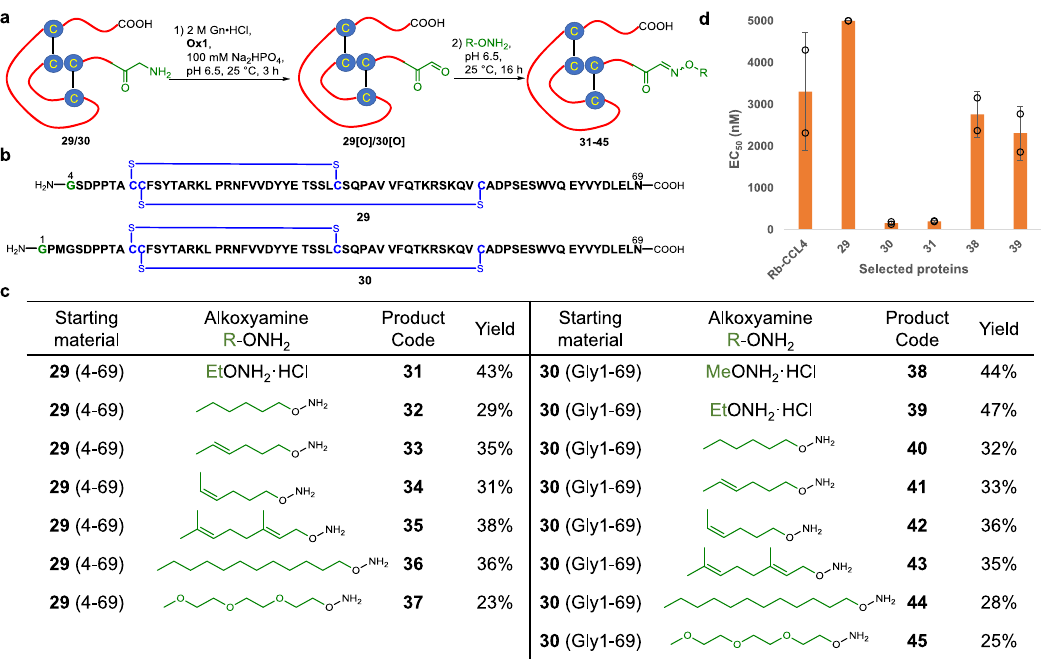
Fig. 6 Late-stage modi fi cation of MIP-1 β proteins via quinone-mediated selective oxidation of N -terminal amine. a Reaction scheme for the transamination of MIP-1 β protein 29 and 30 ; b The sequences of protein 29 and 30 ; c A summary of the transamination/oxime ligation of protein 29 and 30 and the isolated yields for all reactions; d Anti-HIV-1 activity of selected MIP-1 β analogs with EC 50 < 5000nM (Error bars represent standard deviation, n = 2 biological independent protein. Various alkyl alkoxyamines were chosen to optimize the comparison. Ox1 was added into the target protein 29 or 30 in anti-HIV-1 activity of MIP-1 β according to their hydrophobicity buffer solution at pH 6.5 and the solution was incubated at 25 °C (Fig. 6a). Hexyl, ( E )-hexyl, ( Z )-hexyl, geranyl and decyl hydro- for 3 h. Subsequently, after the addition of the alkoxyamine, the xylamine were used to investigate the in fl uence of the hydro- mixture was readjusted to pH 6.5 and reacted for a further 16 h to carbon chains with different conformation or chain lengths afford modi fi ed proteins 31 - 45 (Fig. 6c). MIP-1 β proteins and toward fi ne-tuning the bioactivity (Fig. 6c). In addition, we also MeONH 2 ·HCl or EtONH 2 ·HCl were dissolved well in this buffer solution, and the ligations proceeded smoothly and gave high synthesized PEGylated hydroxylamine as a hydrophilic tag for